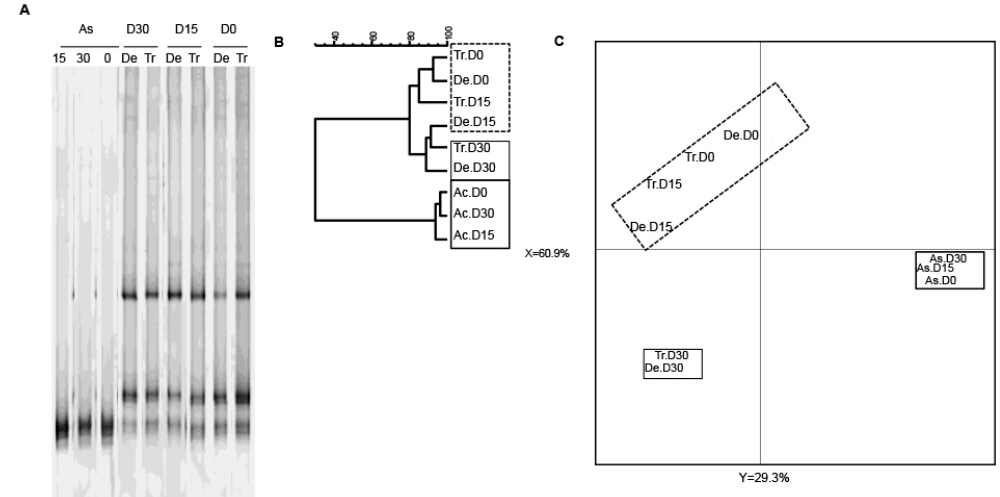
Figure 5. The TTGE fingerprint for bifidobacteria in the three colon reactors after 0, 15 and 30 days of exposure to CPF 1 mg/day in oil (D0, D15 and D30, respectively). ( A ) TTGE of bifidobacterial 16S rRNA gene amplicons of fecal samples taken from the colon vessels (As: ascending; Tr: transverse; De: descending); ( B ) The Pearson dendrogram for the reactor samples at D0, D15 and D30; ( C ) Results of a PCA of the samples from each reactor. The x and y values were 60.9% and 29.3%, respectively.